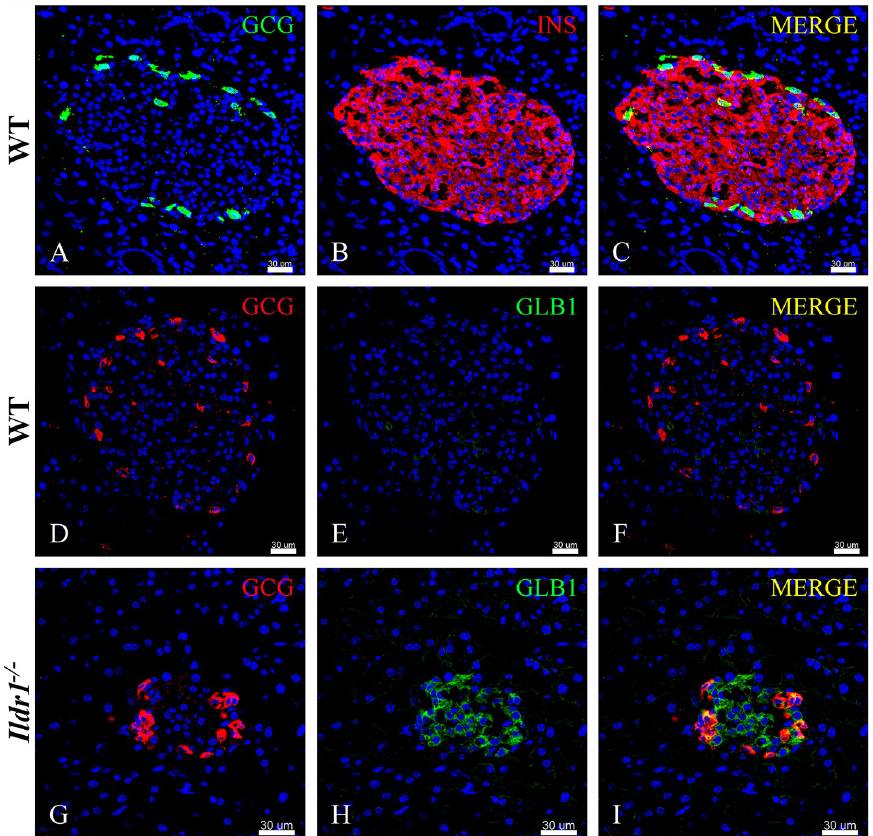
Fig 9. Co-localization of β -galactosidase reporter with glucagon or insulin in mouse pancreatic islets of wild-type (WT) or Ildr1 -/- mice. (A-C) Glucagon (green) and insulin (red) immunostaining in wild-type islets. (A) Glucagon positive alpha cells (green) are present primarily in the periphery of the islet. (B) Insulin positive beta cells (red) comprise the majority of the islet. (C) Merged image of glucagon and insulin immunostaining in a wild-type islet. (D-F) Glucagon (red) and β -galactosidase reporter (GLB1) (green) immunostaining in wild-type islet. (D) A few glucagon expressing cells (red) are present in the periphery of wild-type islets. (E) This islet is negative for β - galactosidase reporterimmunostaining. (F) Merged image of glucagon and β -galactosidase reporter immunostaining in wild-type islet. (G-I) Glucagon (red) and β -galactosidase reporter (green) immunostaining in Ildr1 -/- islet. (G) Similar to wild-type islet, glucagon expressing cells (red) are present in the periphery of Ildr1 -/- islet. (H) However, unlike wild- type islet, in Ildr1 -/- mice, β -galactosidase reporter (green) expression is detected. (I) Glucagon and β -galactosidase reporterantigens appear to co-localize (yellow) in the merged image. β -galactosidase reporter expression was not observed in acinar cells that surround the islets, in accordance with X-gal staining (shown in Fig 1B above). Scale bar is 30 μ m in all the